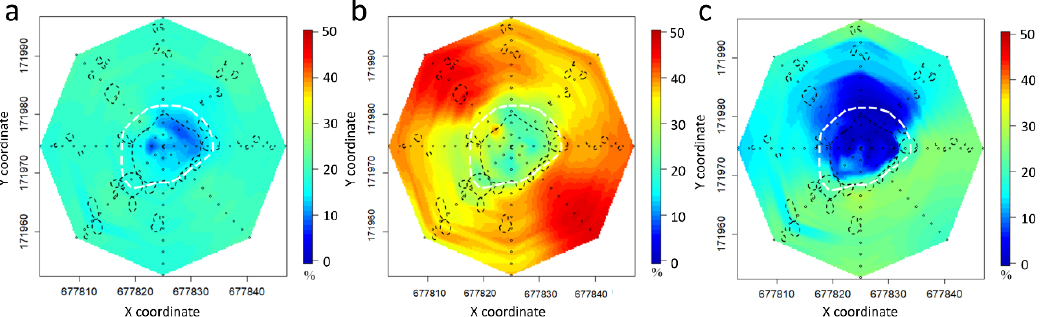
Figure 6. Spatial plots of exceedance rates (%) for VPD values with respect to 3.0 kPa from 24-h period of three measurement periods (coordinates refer to the Hungarian Unified National Projection System (m)); ( a ): May, ( b ): July, and ( c ): October. White dashed line: visual tree edge. Black dashed lines: the position and extent of individual shrubs and poplar sprouts.